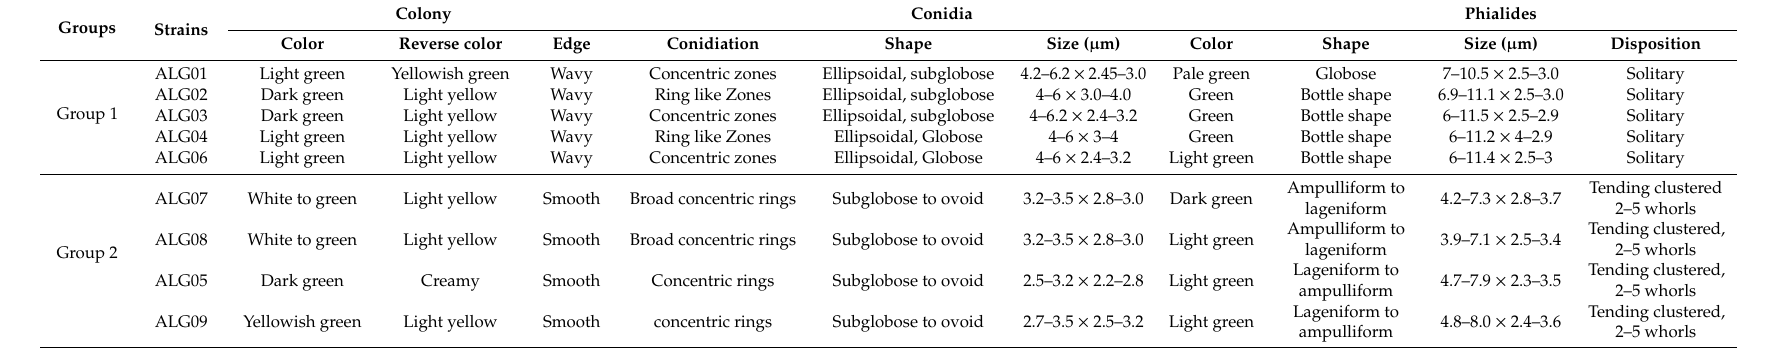
Table 1. Morphological description used for characterization of nine Trichoderma